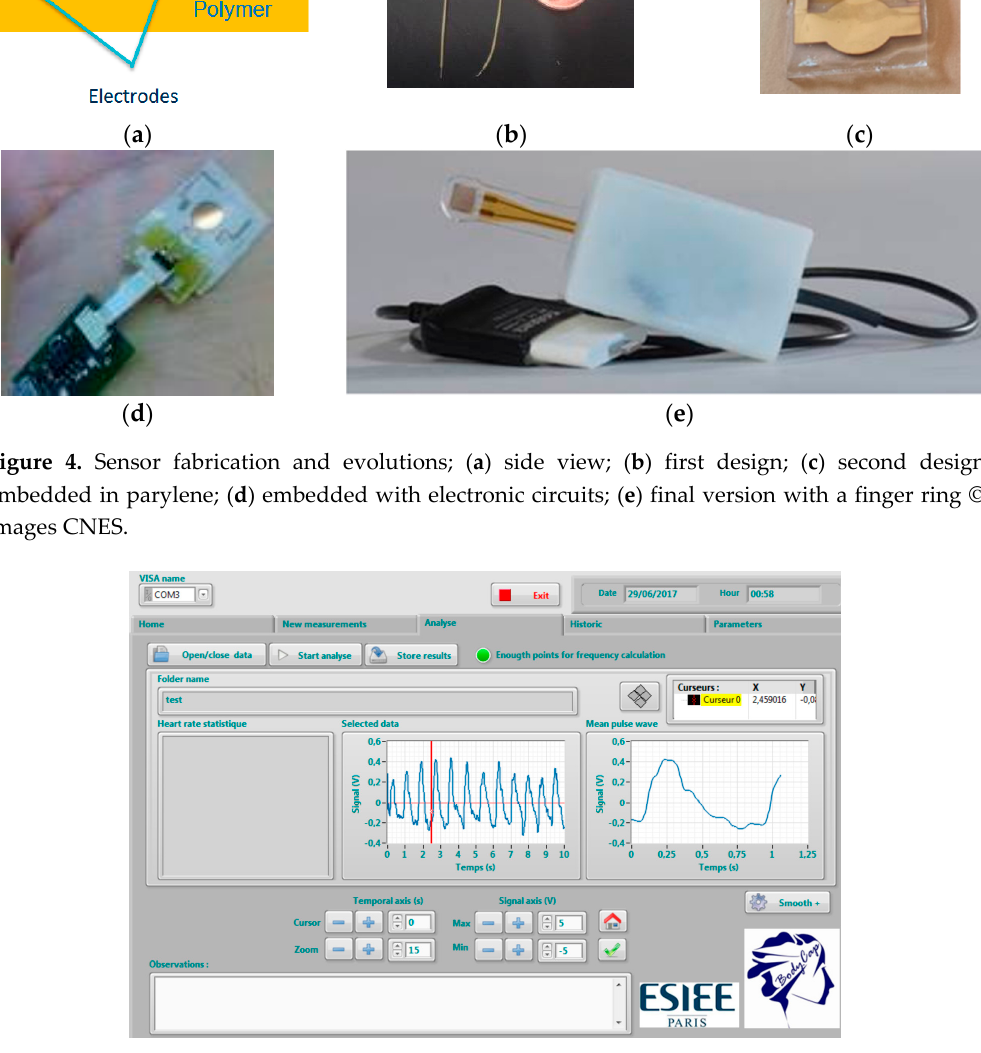
Figure 5. Example of the human machine interface developed to extract the main arterial